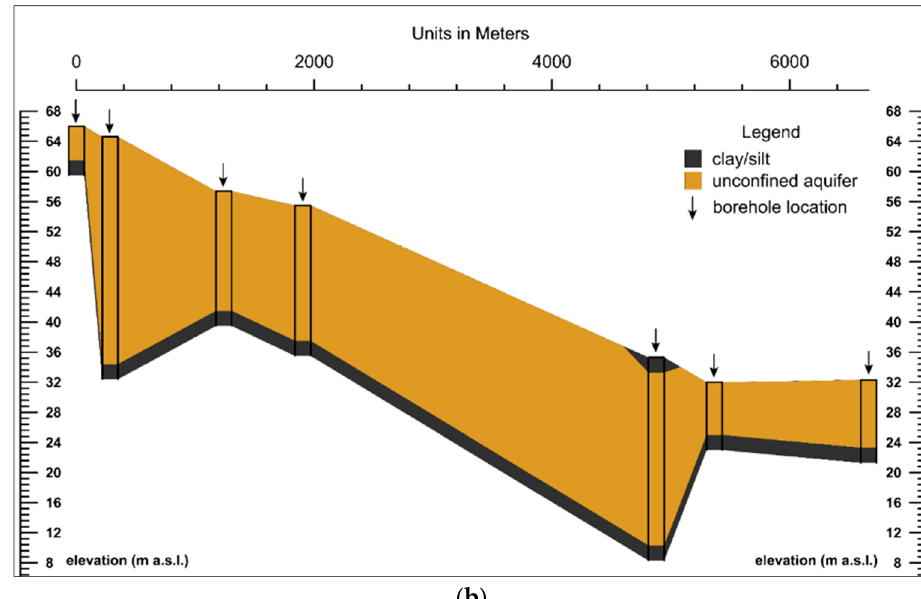
Figure 4. ( a ) Geological cross-section AA’; ( b ) Geological cross-section BB’. The location of both sections is shown in Figure 1b.